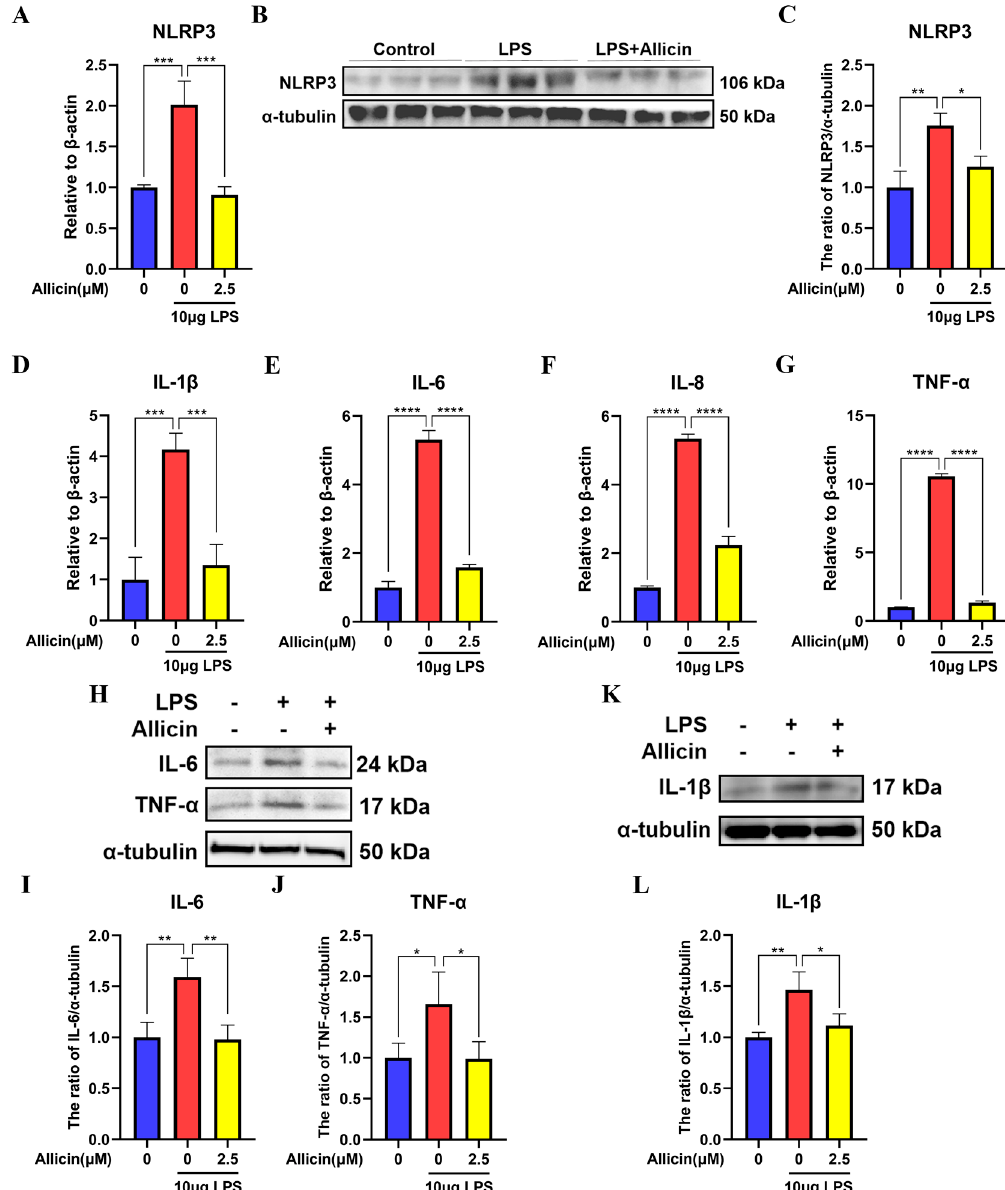
Figure 2. Effect of allicin on NLRP3 inflammasome activation in MAC-T cells. ( A , D – G ) The mRNA levels of NLRP3, IL-1 β , IL-6, IL-8, and TNF- α in MAC-T cells were measured using RT ‒ qPCR with β -actin used as an endogenous control. ( B , C , H – L ) The protein expression levels of NLRP3, IL-1 β , IL-6, and TNF- α were detected using Western blotting, and alpha ( α )-tubulin was used as a control. *, p < 0.05; **, p < 0.01; ***, p < 0.001; ****, p < 0.0001.